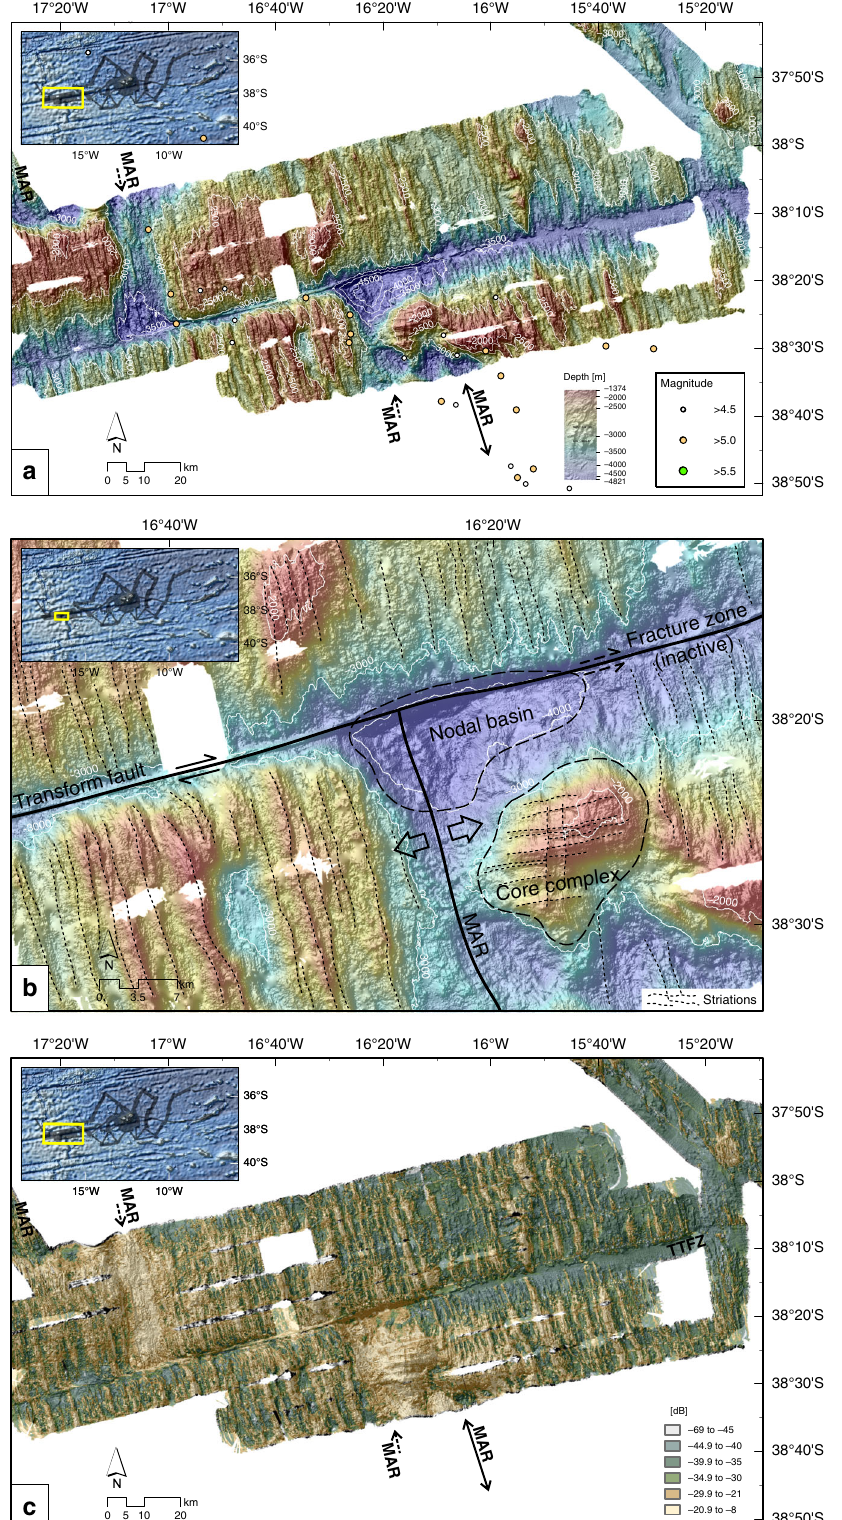
Fig. 8 Bathymetry and seabed backscatter of Mid-Atlantic Ridge area. a Bathymetry for the area close to the Mid-Atlantic Ridge. Dots mark earthquake epicenters from teleseismic observations 52 . The hillshade is illuminated by an azimuth of 315°. b Close-up of the oceanic core complex. c Seabed backscatter data illustrating abyssal hills and oceanic core complex. Unclassi fi ed greyscale version is shown in Supplementary Fig. 3c. MAR Mid-Atlantic Ridge; TTFZ Tristan da Cunha Transform Fault And Fracture Zone